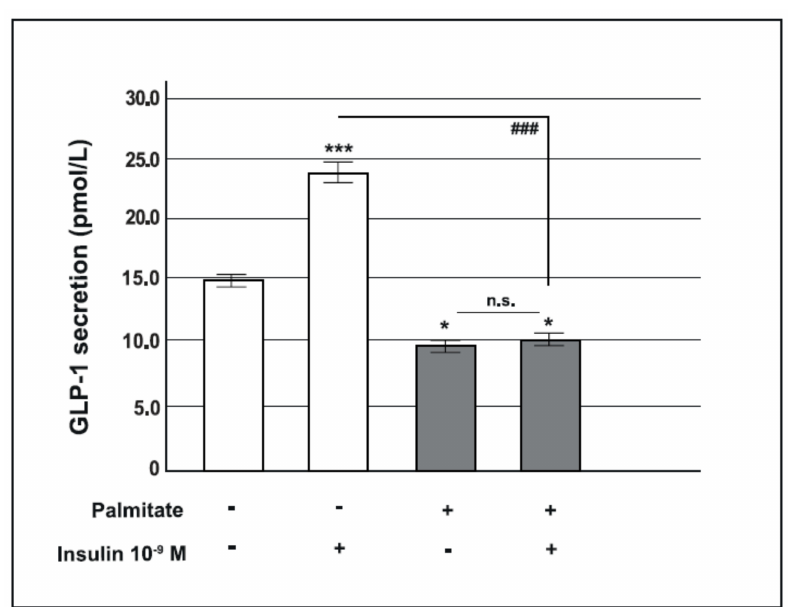
Figure 2. Effect of pre-exposure to palmitate on glucagon-like peptide-1 (GLP-1) secretion in GLUTag cells. Acute insulin-induced GLP-1 secretion in control cells (open bars) and in cells pre-exposed to 0.5 mM of palmitate for 24 h (gray bars). * p < 0.05, *** p < 0.001 vs. basal level in control group; ### p < 0.001 vs. insulin stimulated control group, n.s. not significant (1-way ANOVA followed by Bonferroni test, n = 4); (+) means presence, (-) means